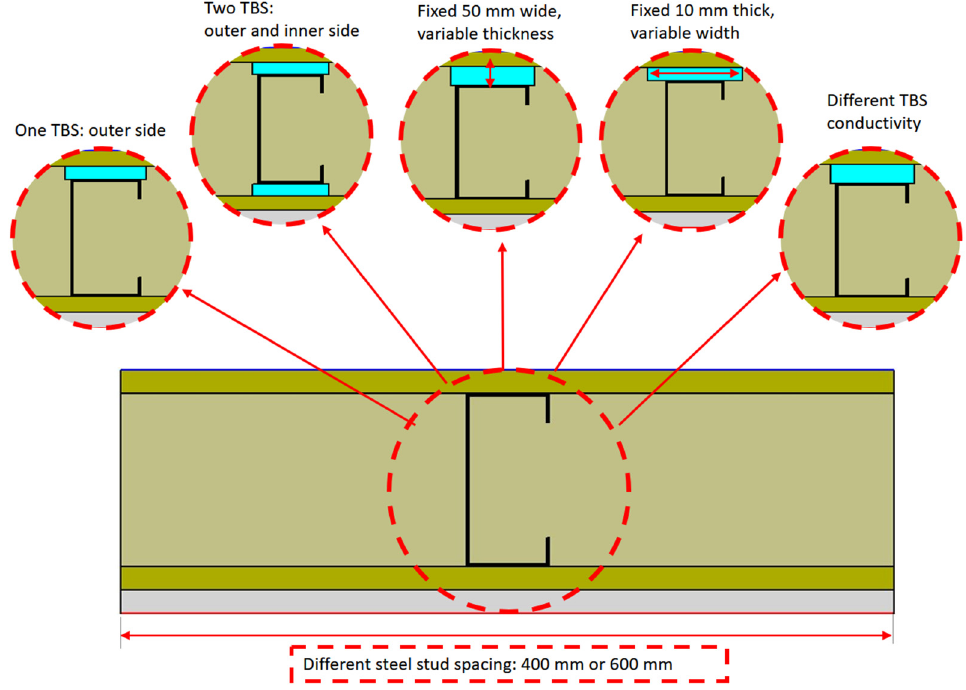
Figure 2. Evaluated parameters in the sensitivity analysis. Table 1. Parameters to be evaluated and assigned